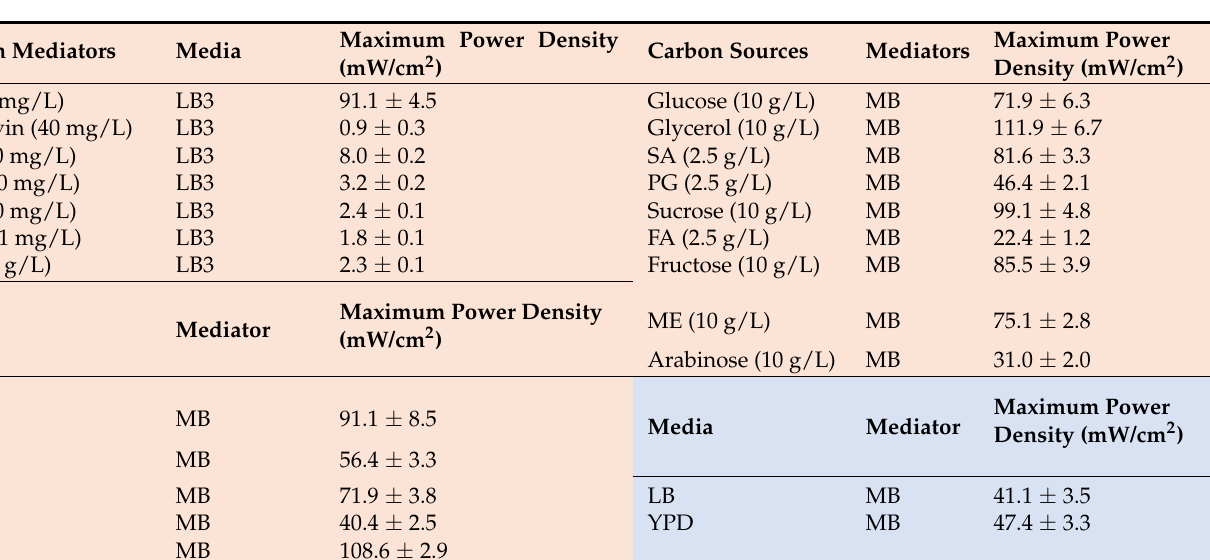
Table 1. The maximum power density of MFCs with electron mediators, media, and carbon sources